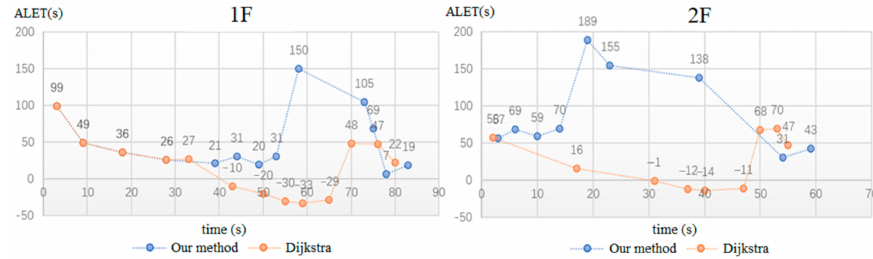
Figure 26. ALET comparison of two